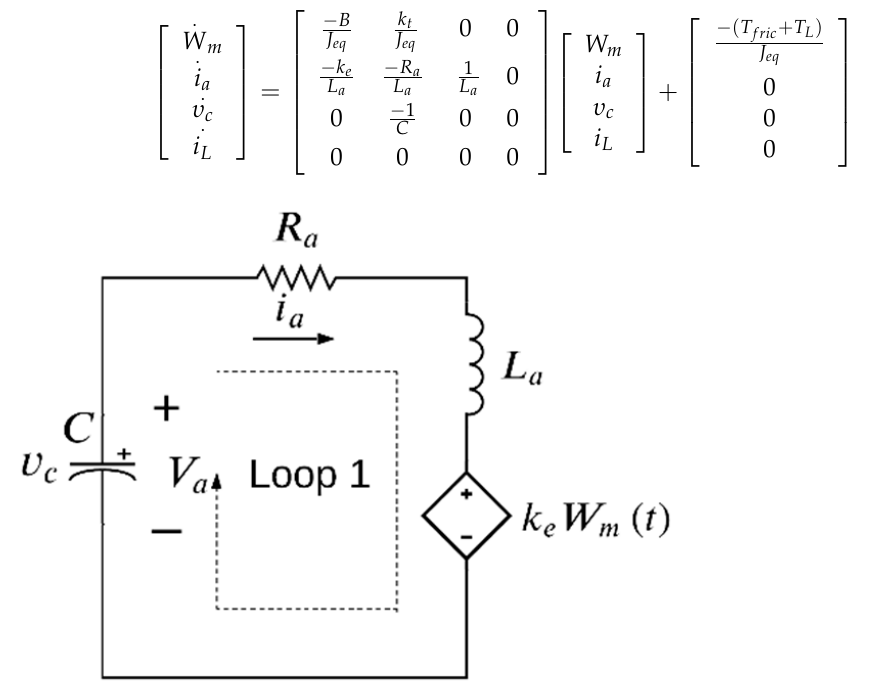
Figure 5. Model of the buck-motor system in discontinuous conduction mode. The following step is used to configure the CPWM to send a signal with a pulse to the center. Additionally, the buck converter is configured to work in continuous conduction mode. The dynamic response of the system in a complete period can be written as in Equation (6):